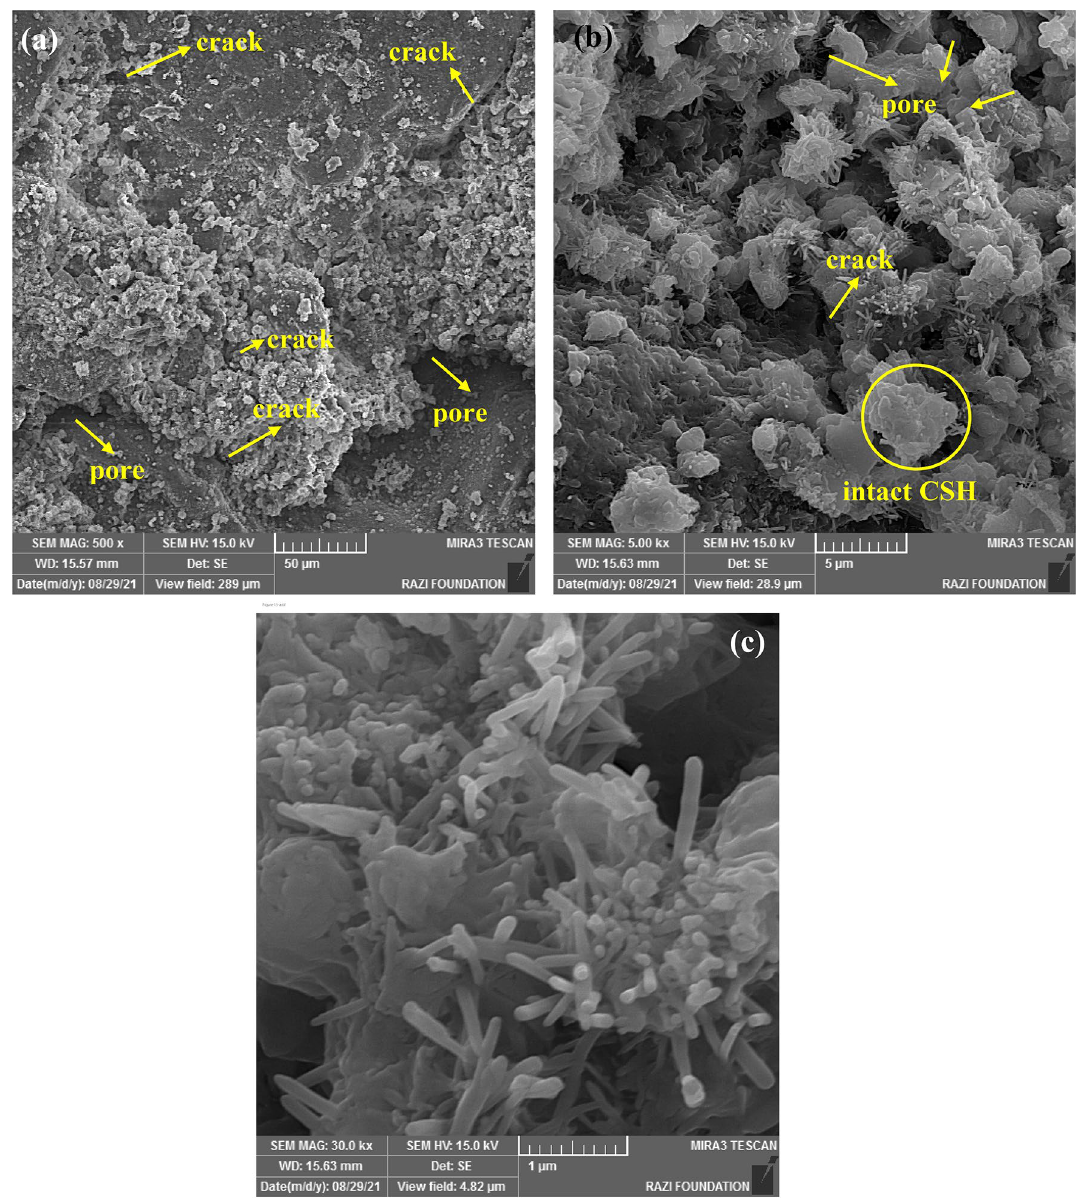
Fig. 15 The scanning electron microscope (SEM) images of mixture with 10% cement subjected to the 8th F-T cycle: a 500× magnification, b 5000× magnification, c 30,000×